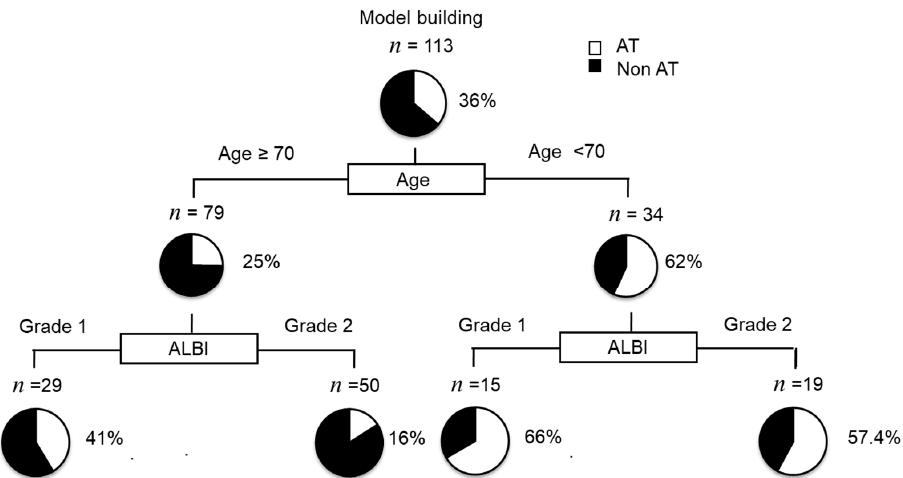
Figure 4. Profiles associated with alternating lenvatinib (LEN) and trans-arterial therapy (AT) in hepatocellular carcinoma (HCC) patients treated with LEN, and the decision tree algorithm for AT. The pie graphs indicate the percentage of AT (white)/non-AT (black) in each group.